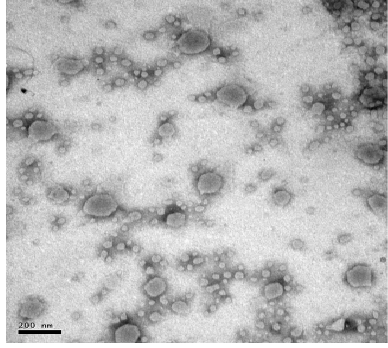
Figure 1. Transmission electron micrograph of MRPL.